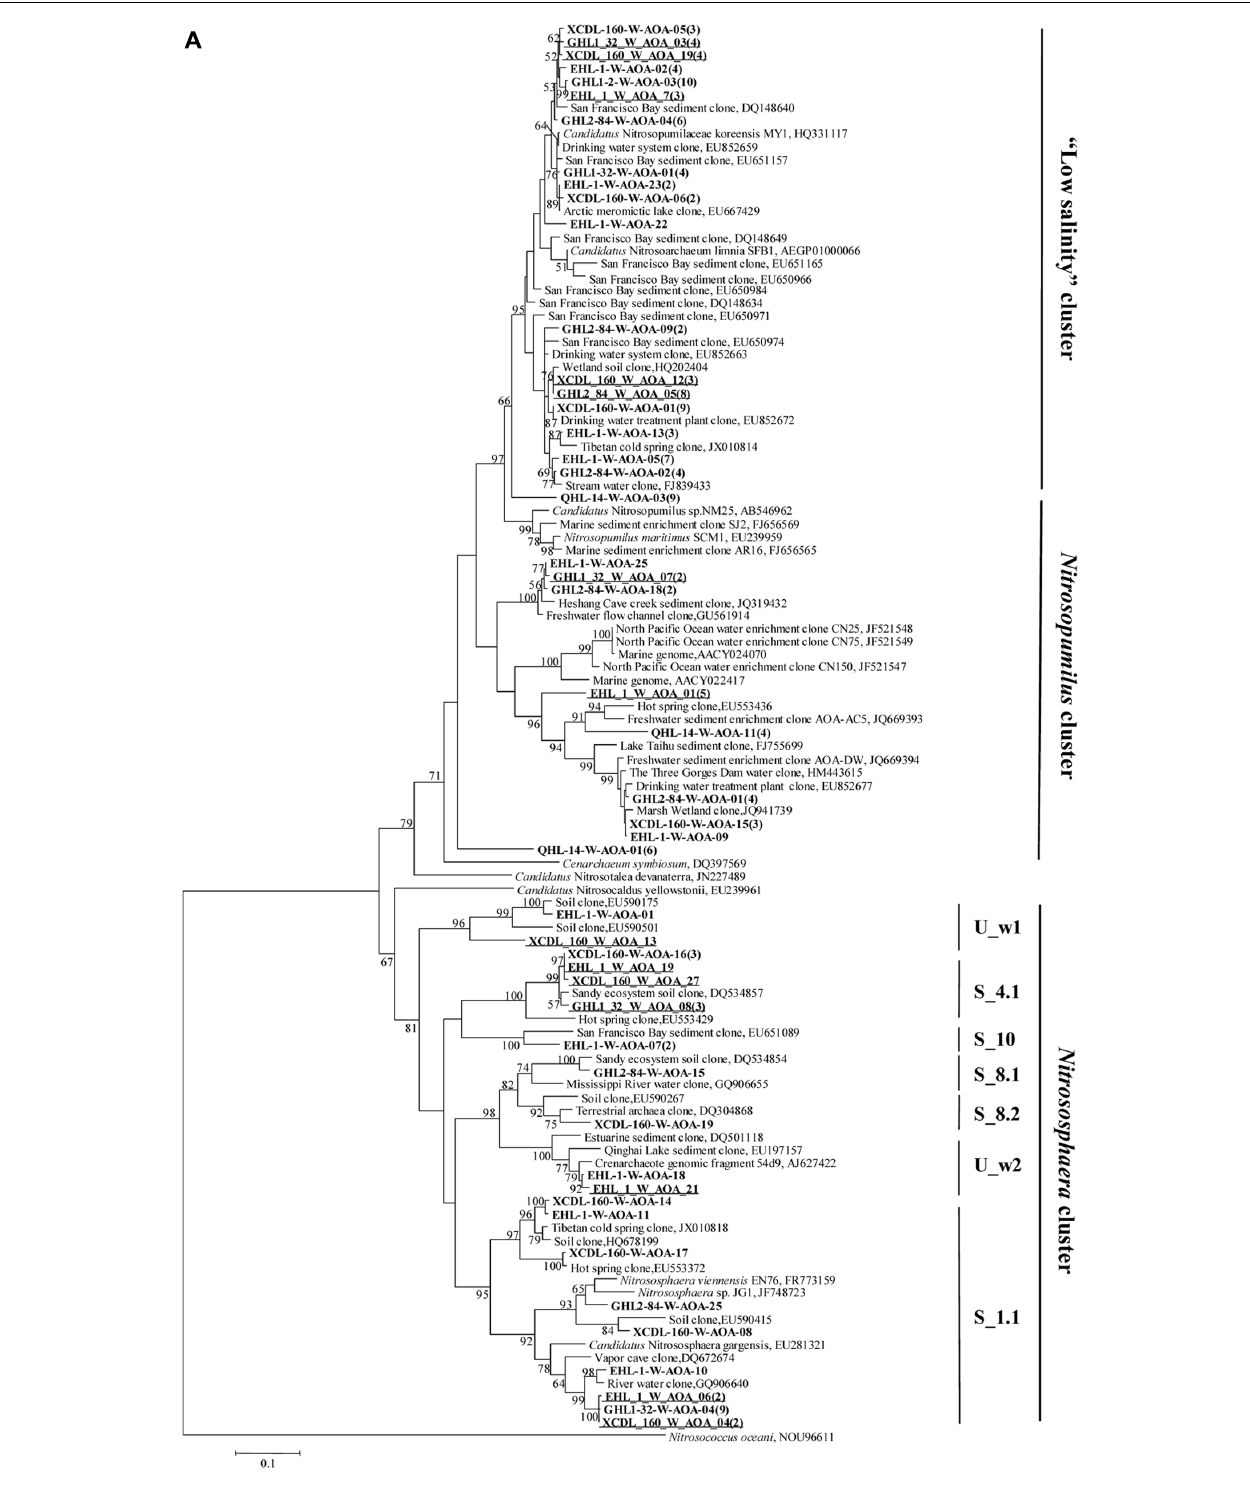
FIGURE 5 | Maximum likelihood tree (partial sequences, 635 or 629 bp) showing the phylogenetic relationships of the amoA gene clone sequences obtained in this study to their closely related sequences from the GenBank database. One representative clone type within each OTU is shown, and the number of clones within each OTU is shown in